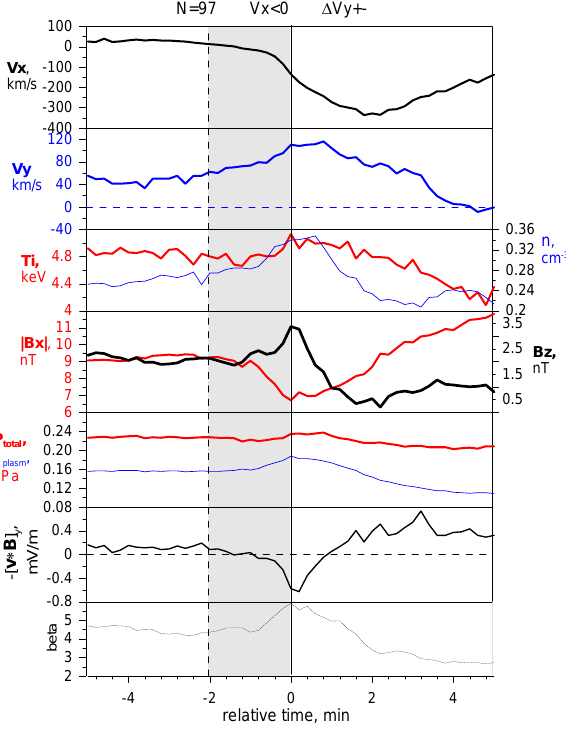
Fig. 10. The same as in Fig. 7 for one group of the tailward moving fast